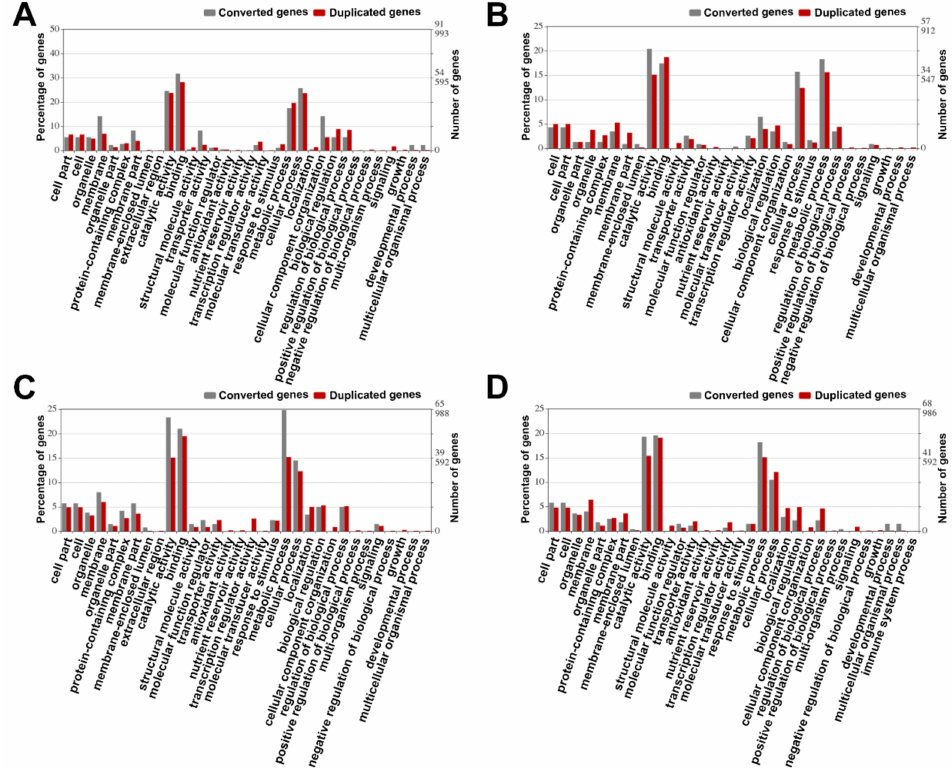
Figure 6. Histogram of gene ontology (GO) statistics for converted and all duplicated genes. ( A ) GO statistics for converted genes and duplicated genes in A. hypogaea A (Shitouqi). x -axis shows user-selected GO terms; y -axis shows the percentages of genes (number of a particular gene divided by total gene number). ( B ) GO statistics for converted genes and duplicated genes in A. hypogaea B (Shitouqi). ( C ) GO statistics for converted genes and duplicated genes in A. hypogaea A (Tifrunner). ( D ) GO statistics for converted genes and duplicated genes in A. hypogaea B